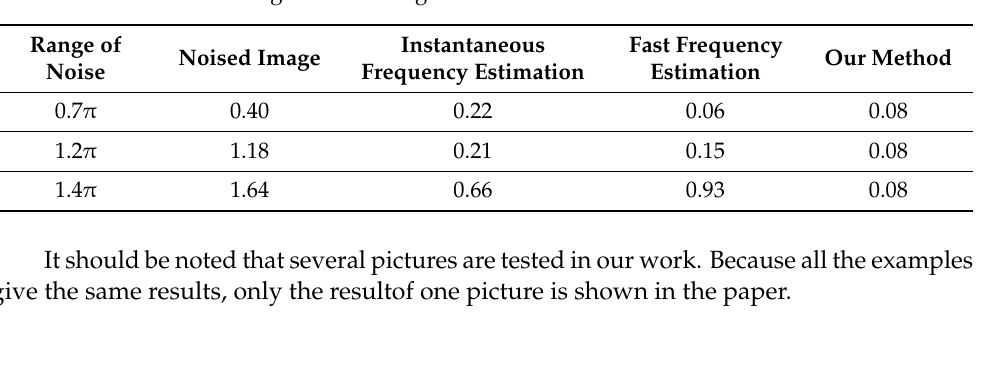
Figure 10. The noised atmospheric turbulence phase map and its corresponding filtered and re- wrapped results. Table 2. MSE of each filtering method of Figure 10.